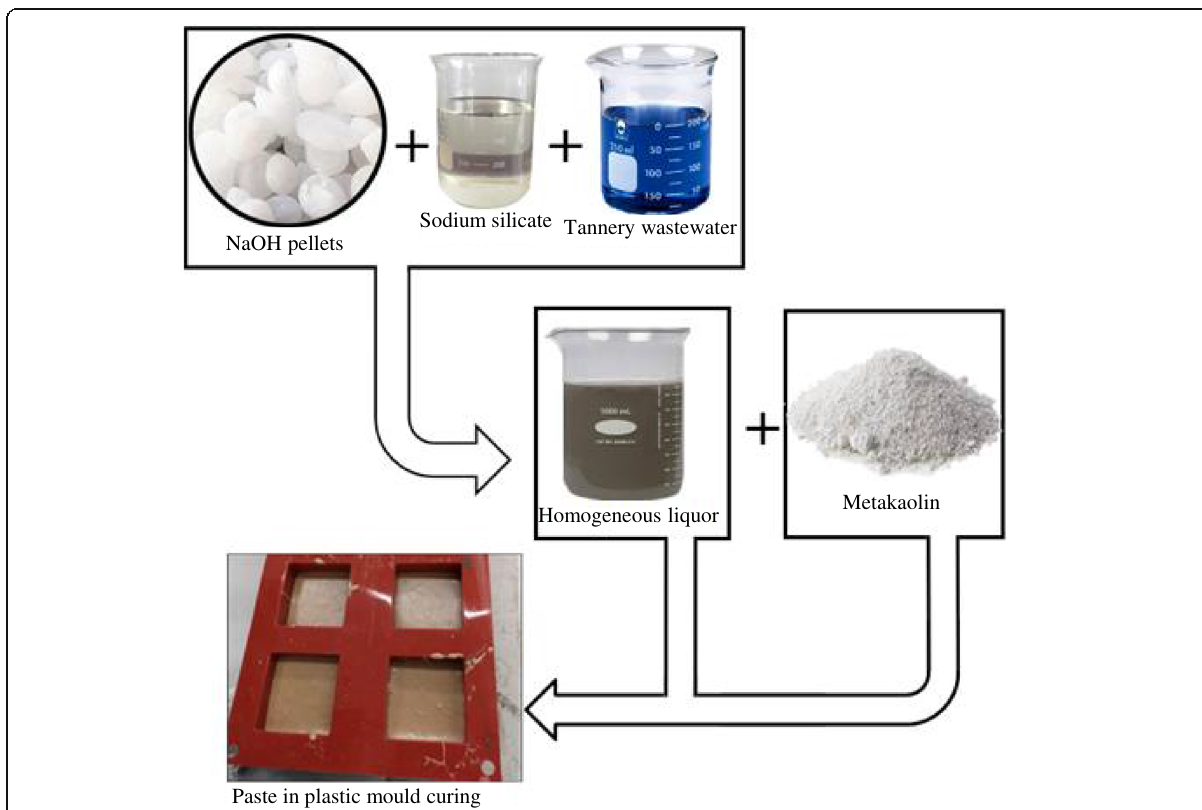
Fig. 1 Schematic representation of the Geopolymer preparation steps as described in the